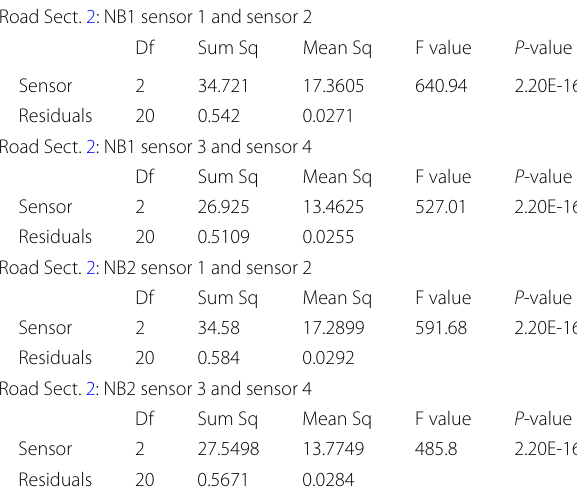
Table 4 Results of ANOVA tests on two sensors that mounted on the same side of the vehicle for two road